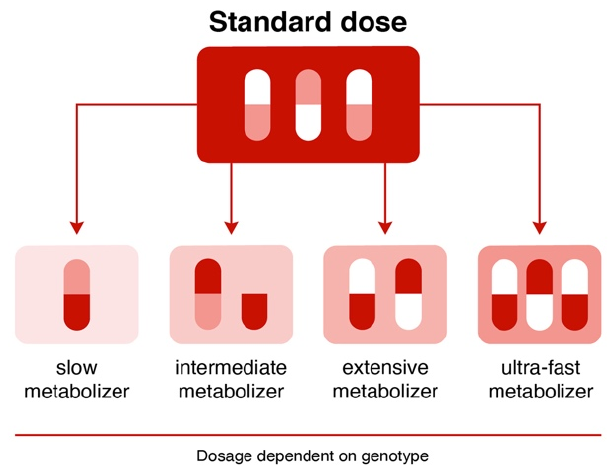
Figure 4. Pharmacogenetic phenotypes ([74], modified by the authors).